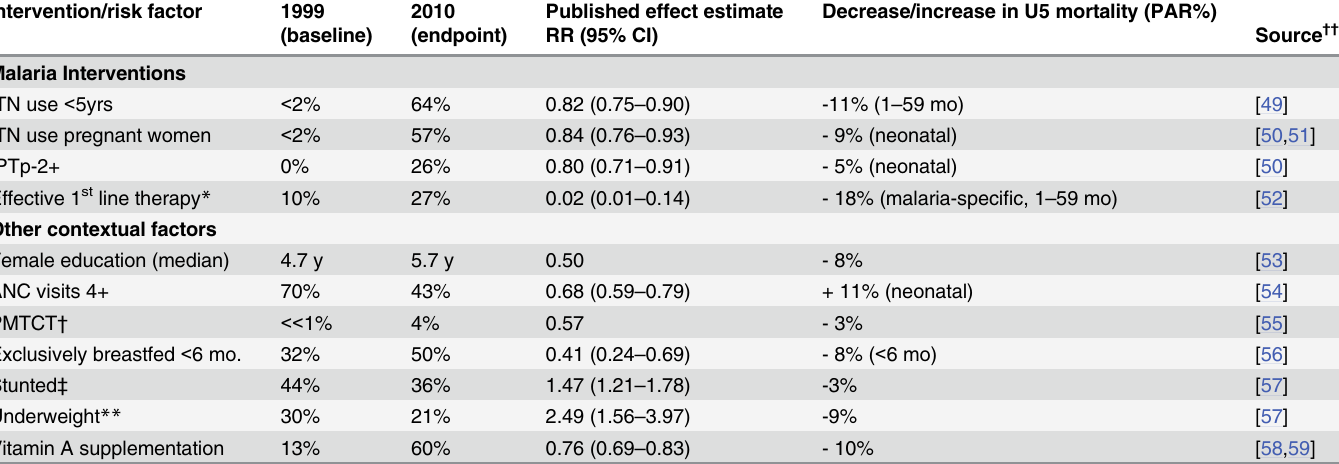
Table 5. Coverage estimates of important child survival interventions and corresponding relative risk estimates with predicted proportions of all- cause under-5 mortality averted (or increased) in Mainland Tanzania, 1999 –